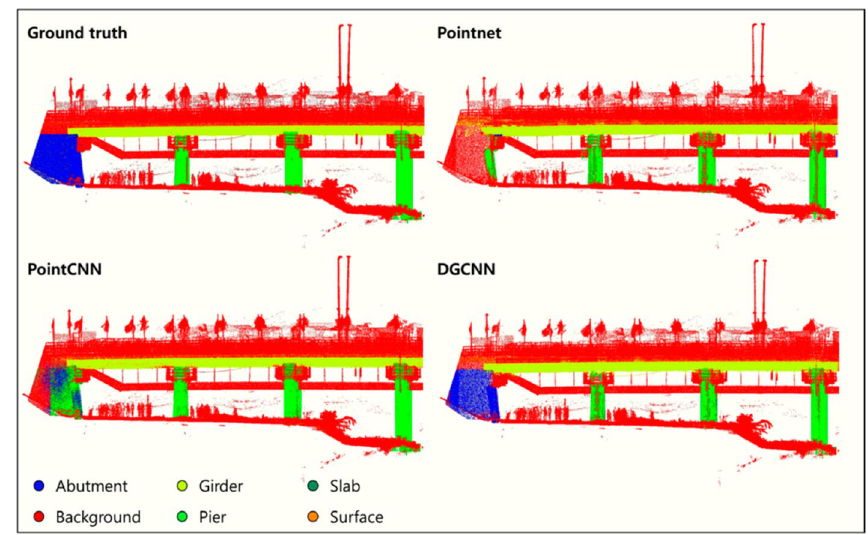
Fig. 10 Identification results of points clouds in the research of Kim and Kim (2020)